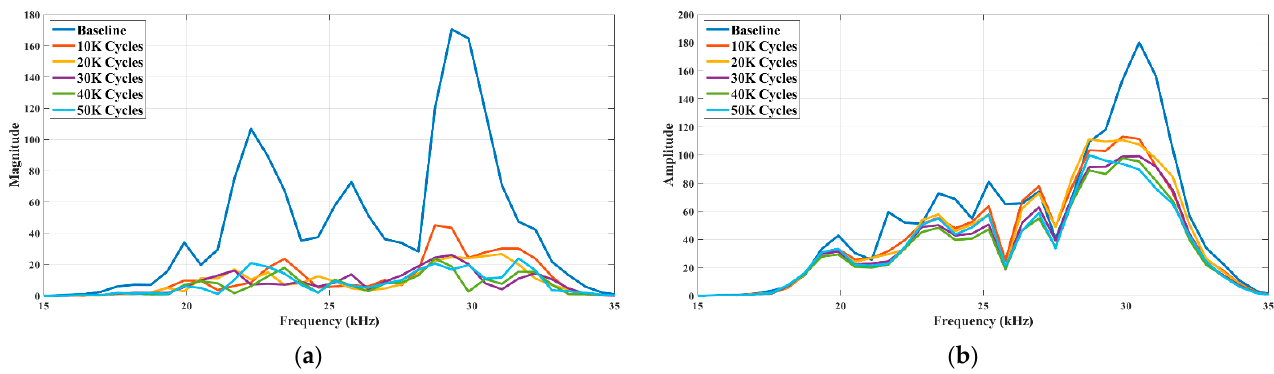
Figure 3. Frequency-domain signal for the ( a ) 5–10 and ( b ) 3–8 path.